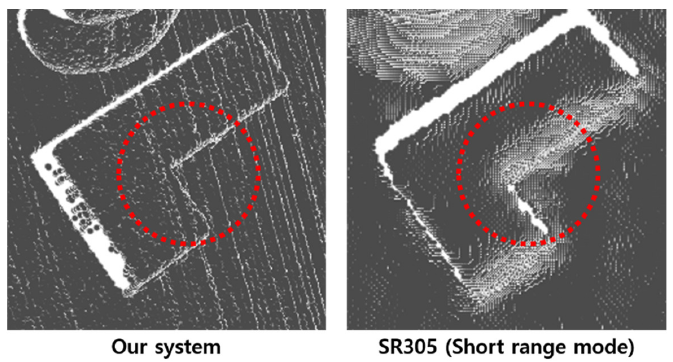
Figure 16. Comparison of the result that was scanned a cube object using two devices.